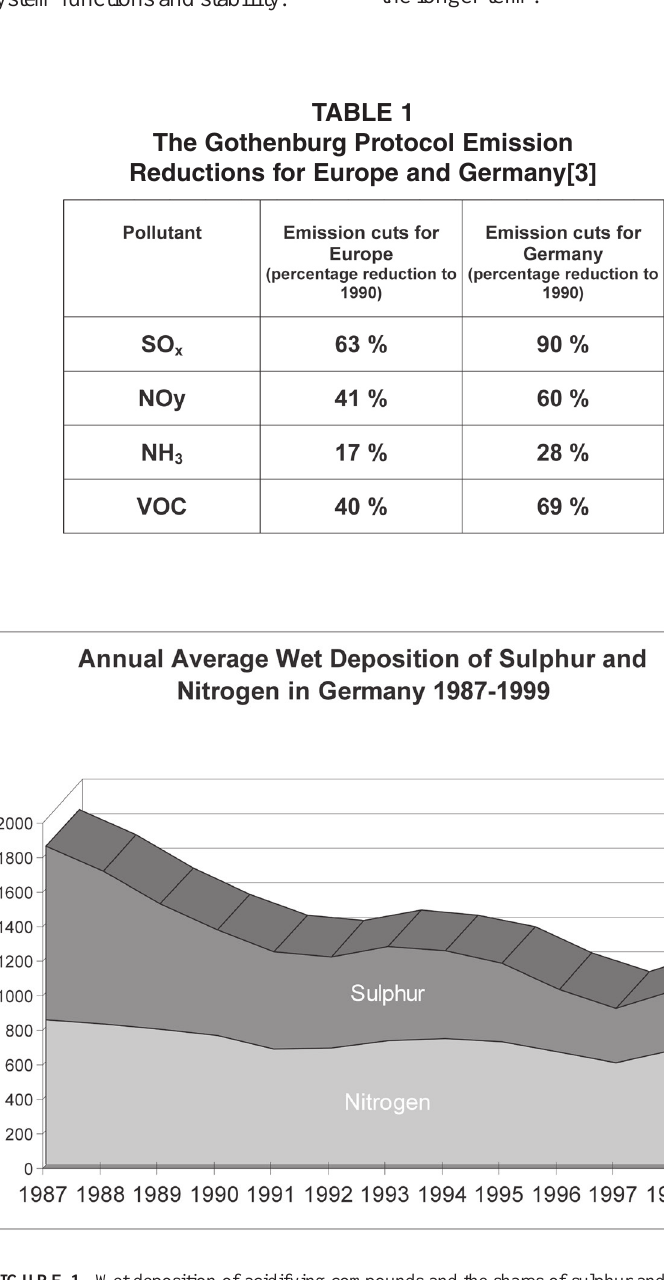
FIGURE 1 . Wet deposition of acidifying compounds and the shares of sulphur and